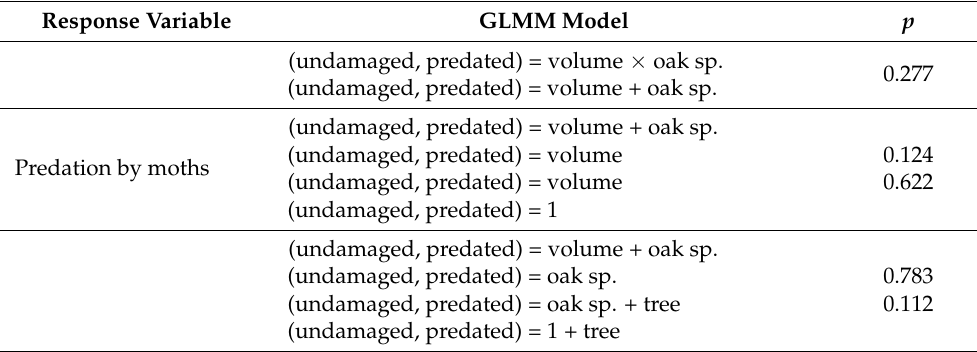
Figure 3. Acorn predation probability vs. acorn volume in Quercus rugosa (continuous line) and Q. castanea (dotted line). Table 4. Generalized linear mixed effects models (GLMMs) used to analyze the effects of seed size (volume) and oak species on pre-dispersal predation by moth larvae. The p -values indicate the significance of the likelihood ratio test among pairs of models ( n =